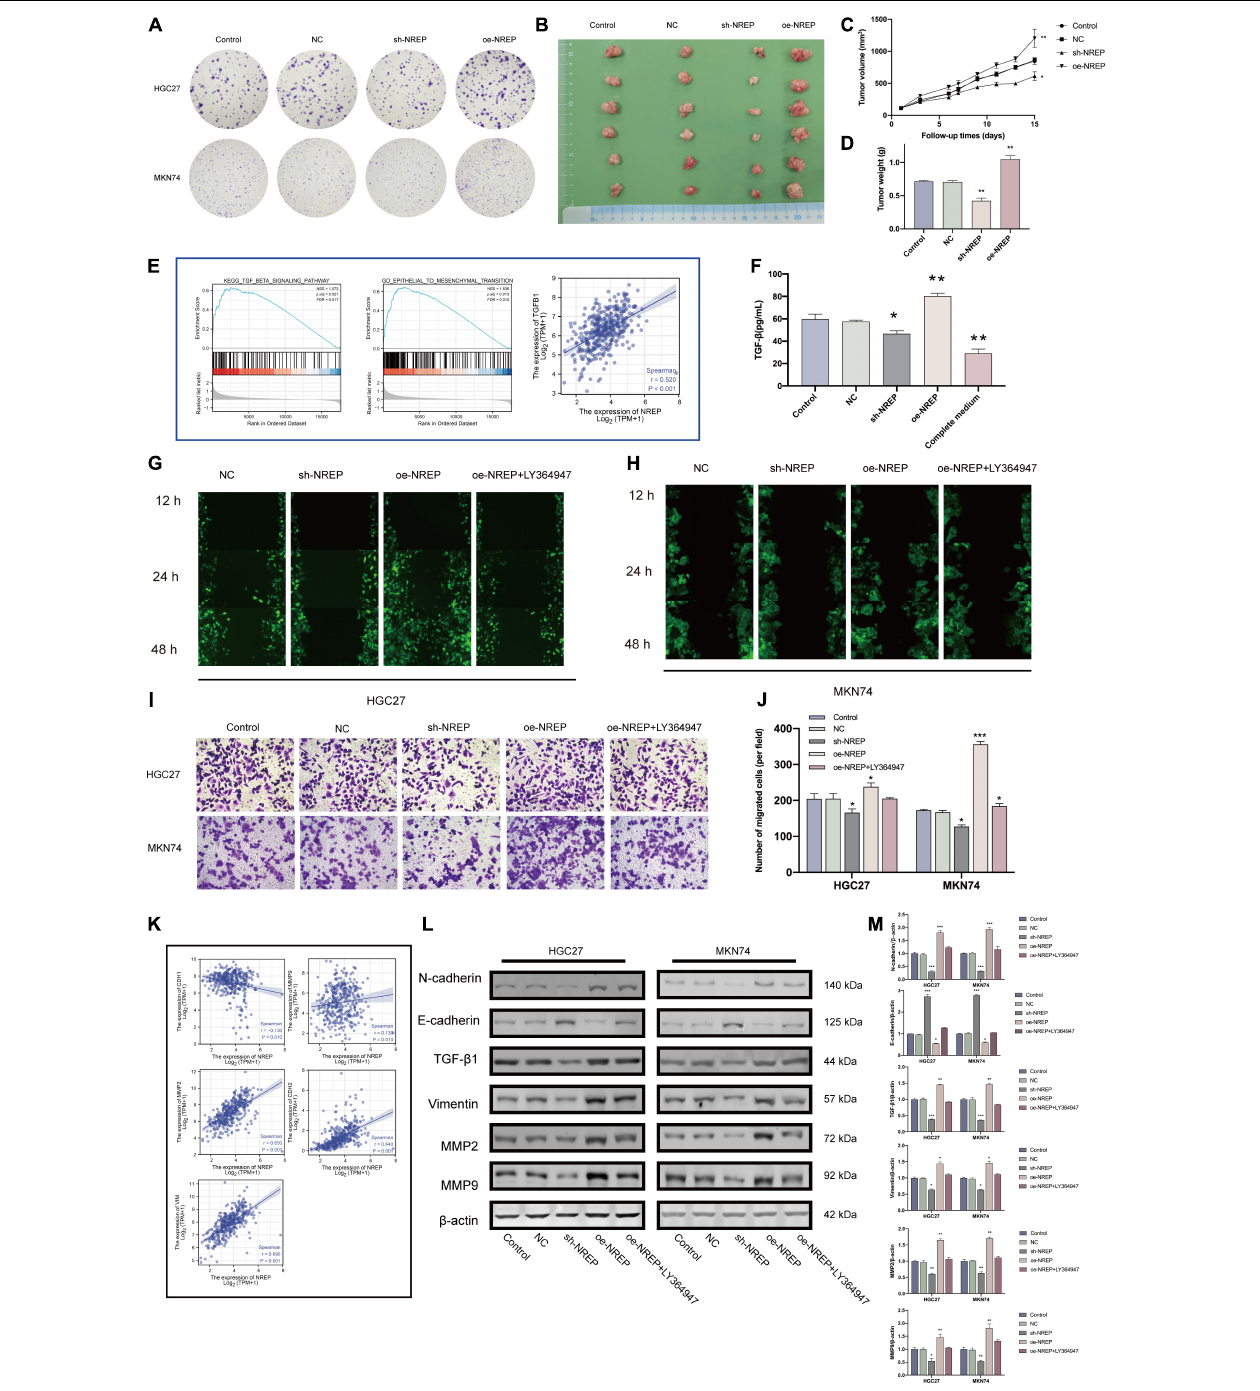
FIGURE 4 | NREP overexpression promotes a malignant phenotype in gastric cancer (GC). (A) Clone formation capacity of GC cells transfected with the NC, sh- NREP, and oe-NREP constructs assessed using the clone formation assay. (B) Xenograft tumors from nude mice. (C,D) Tumor volume (C) and weights (D) of xenografts from nude mice (E) Gene Set Enrichment Analysis (GSEA) of NREP and correlation analysis between NREP and TGF- β 1 expression using TIMER. (F) TGF- β 1 levels in the supernatant of GC cells transfected with NC, sh-NREP, and oe-NREP examined using ELISA. (G,H) Migratory ability of different group of GC cells [ (G) : HGC27, (H) : MKN74] examined using wound healing assays. (I,J) The invasion ability of GC cells after transfection (I ; magnification, × 200); the relative invasive cell number is shown toward the right in (J) . (K) Correlation coefficient circles for NREP and EMT-related genes (TIMER). (L) Expression of EMT-related proteins examined using western blots after the transfection of GC cells with NC, sh-NREP, and oe-NREP constructs and treatment with 5 µ M LY364947, an inhibitor specific to TGF- β type I receptor. (M) Statistical analysis of western blot results. (* P < 0.05, ** P < 0.01, and *** P < 0.001).